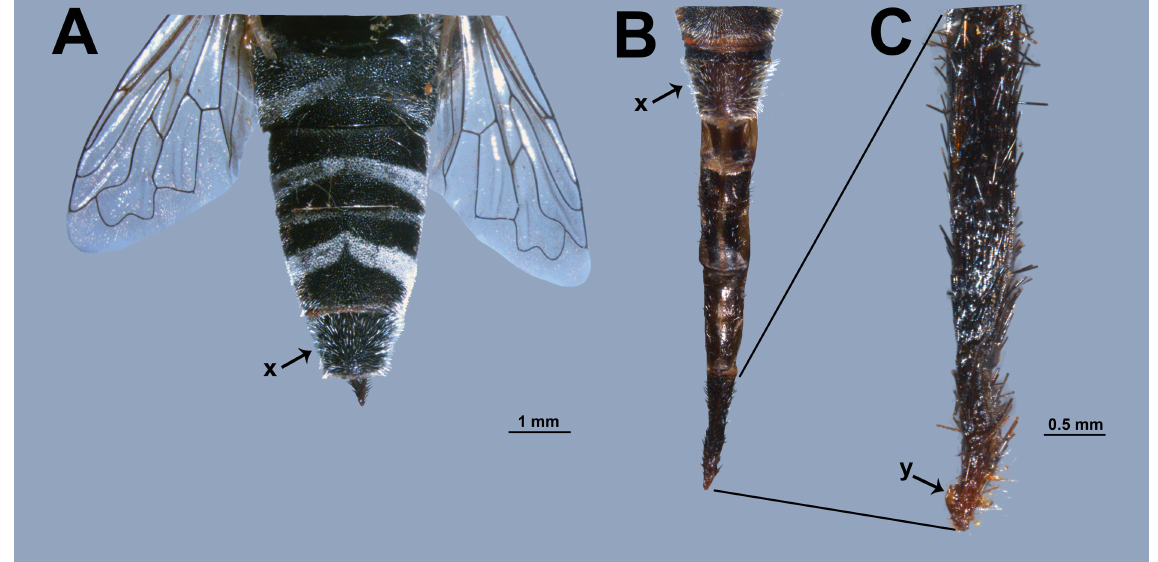
Fig. 8. Megatrigon nivalis (Hull, 1964) comb. nov., abdomen, dorsal view, ♀. A . Habitus,